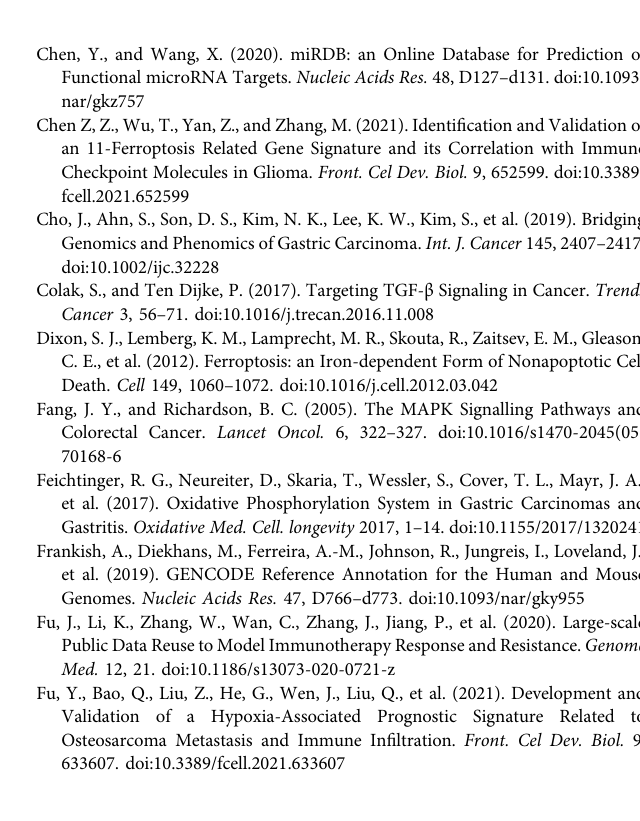
the sensitivity and speci fi city. (B) The KM survival curves showed a higher survival rate in the low-risk group. (C) Risk scores for stomach patients with STAD were presented in ascending order. (D) The survival status distribution curve showed a higher proportion of dead patients in the high-risk group. (E) The expression heatmap of these 10 lncRNAs was plotted and signi fi cance levels were annotated on the right side. **** p < 0.0001, *** p < 0.001, ** p < 0.01, * p < 0.05. Supplementary Figure 2 | Validation of the prognostic model in the test2 cohort. (A) Time-independent ROC curves along with their AUC were conducted to assess the sensitivity and speci fi city. (B) The KM survival curves showed a higher survival rate in the low-risk group. (C) Risk scores for patients with STAD were presented in ascending order. (D) The survival status distribution curve showed a higher proportion of dead patients in the high-risk group. (E) The expression heatmap ofthese 10lncRNAs wasplotted and signi fi cance levels were annotated on theright side. **** p < 0.0001, *** p < 0.001, ** p < 0.01, * p < 0.05. Supplementary Figure 3 | The KM survival curves of these 10 lncRNAs with different expression levels were plotted. Based on their median values, lncRNAs were divided into high and low expression groups. Supplementary Figure 4 | The association between risk scores and clinicopathological factors in the test2 cohort. Supplementary Figure 5 | (A) Risk scores for patients with or without distant metastases were compared. The KM survival analyses in two pathological M subgroups were conducted, including (B) patients without distant metastases (M0) and (C) patients with distant metastases (M1). Supplementary Figure 6 | The association between the expression of lncRNAs andclinicopathologicalfactorsinthetest2cohort.**** p < 0.0001,*** p < 0.001,** p < 0.01, * p < 0.05. Supplementary Figure 7 | Functional analysis of these 10 lncRNAs. The top 20 results of GO terms in BP (A, B) and KEGG pathways (C, D) were shown. P-value and q-value were both 0.05 as cutoff